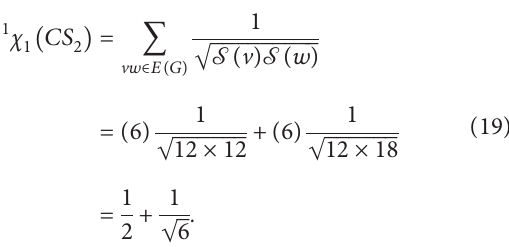
( CS ) can be computed as follows: 3 1